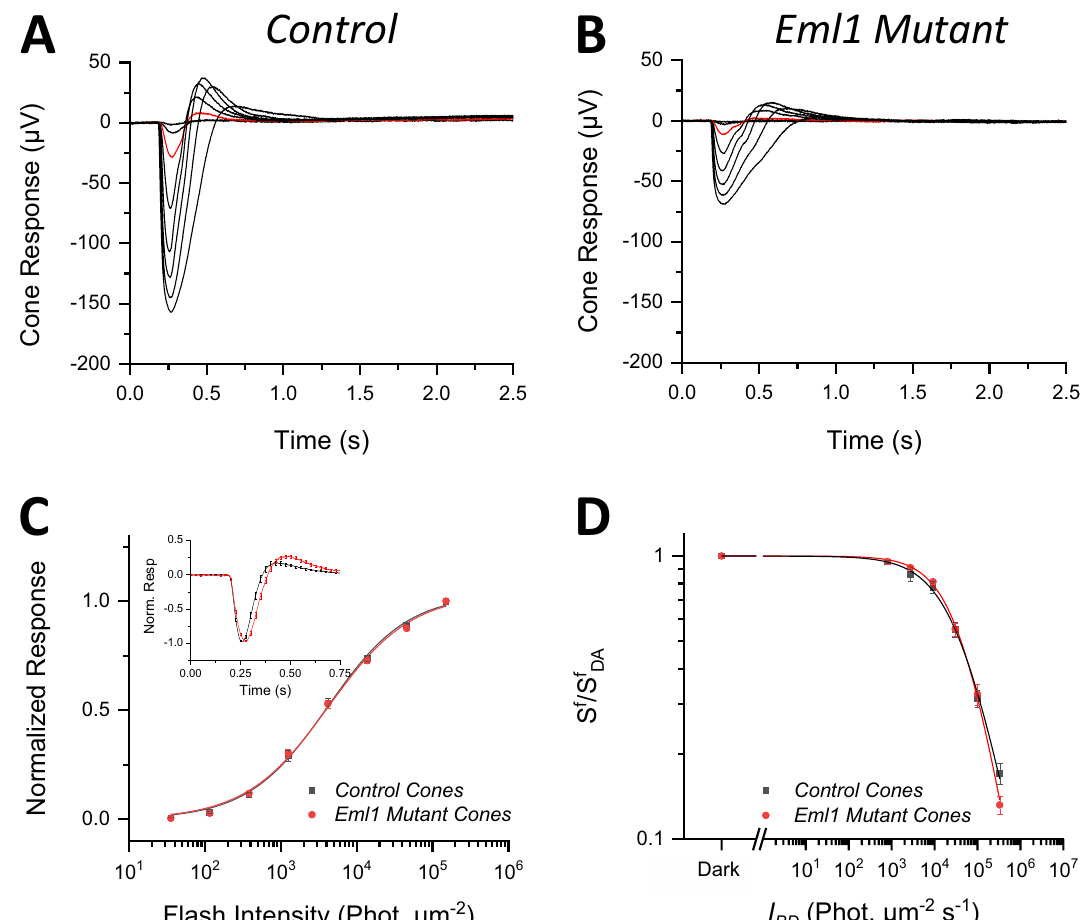
Figure 5. Effect of Eml1 mutation on cone ERG responses. Representative cone responses to a family of flashes (photons μm −2 ): 35, 116, 382, 1260, 4170, 13,800, 45,600 and 151,000 from wild type ( A ) and Eml1 mutant ( B ) mice. For comparison, the responses to a flash of 382 photons μm −2 are highlighted in red. ( C ) Ensemble- average normalized responses of control and Eml1 mutant cones plotted as a function of flash intensity and fitted by the Naka-Rushton function. ( C , inset) Averaged normalized dim flash responses of control and Eml1 mutant cones. ( D ) A plot of average normalized sensitivity as a function of background light intensity from the control and Eml1 mutant cones in light adapted conditions. The lines are fits calculated using a Weber-Fechner function. Error bars show S.E.M for all data.